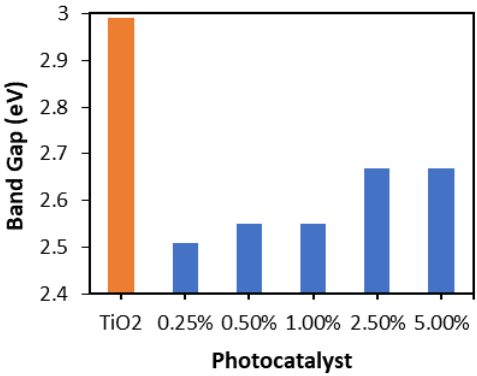
Figure 2. Effect of Pd loading on the optical band gap .